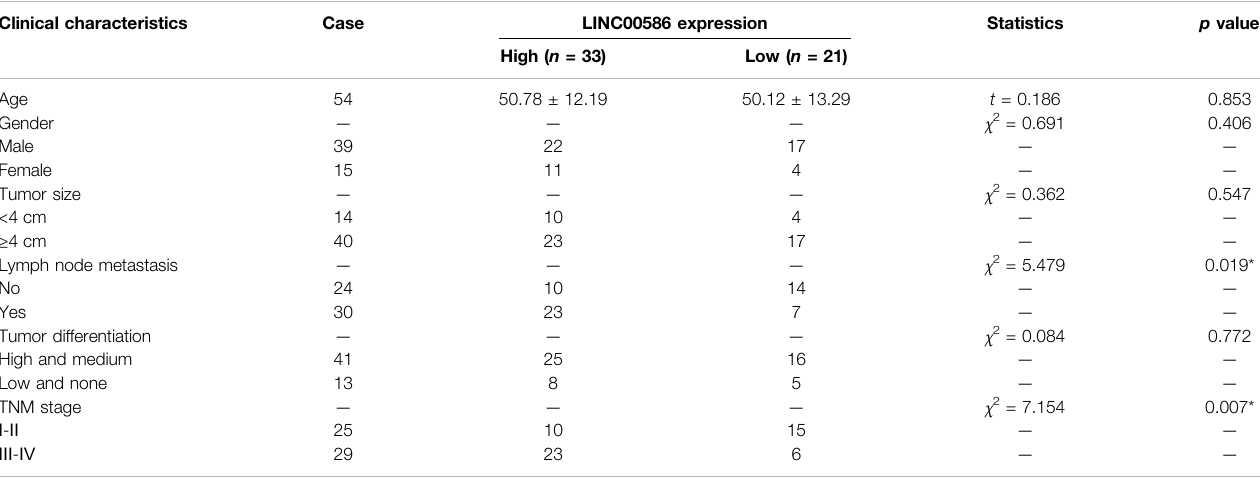
TABLE 2 | Correlation of LINC00586 expression with the clinical characteristics of CRC